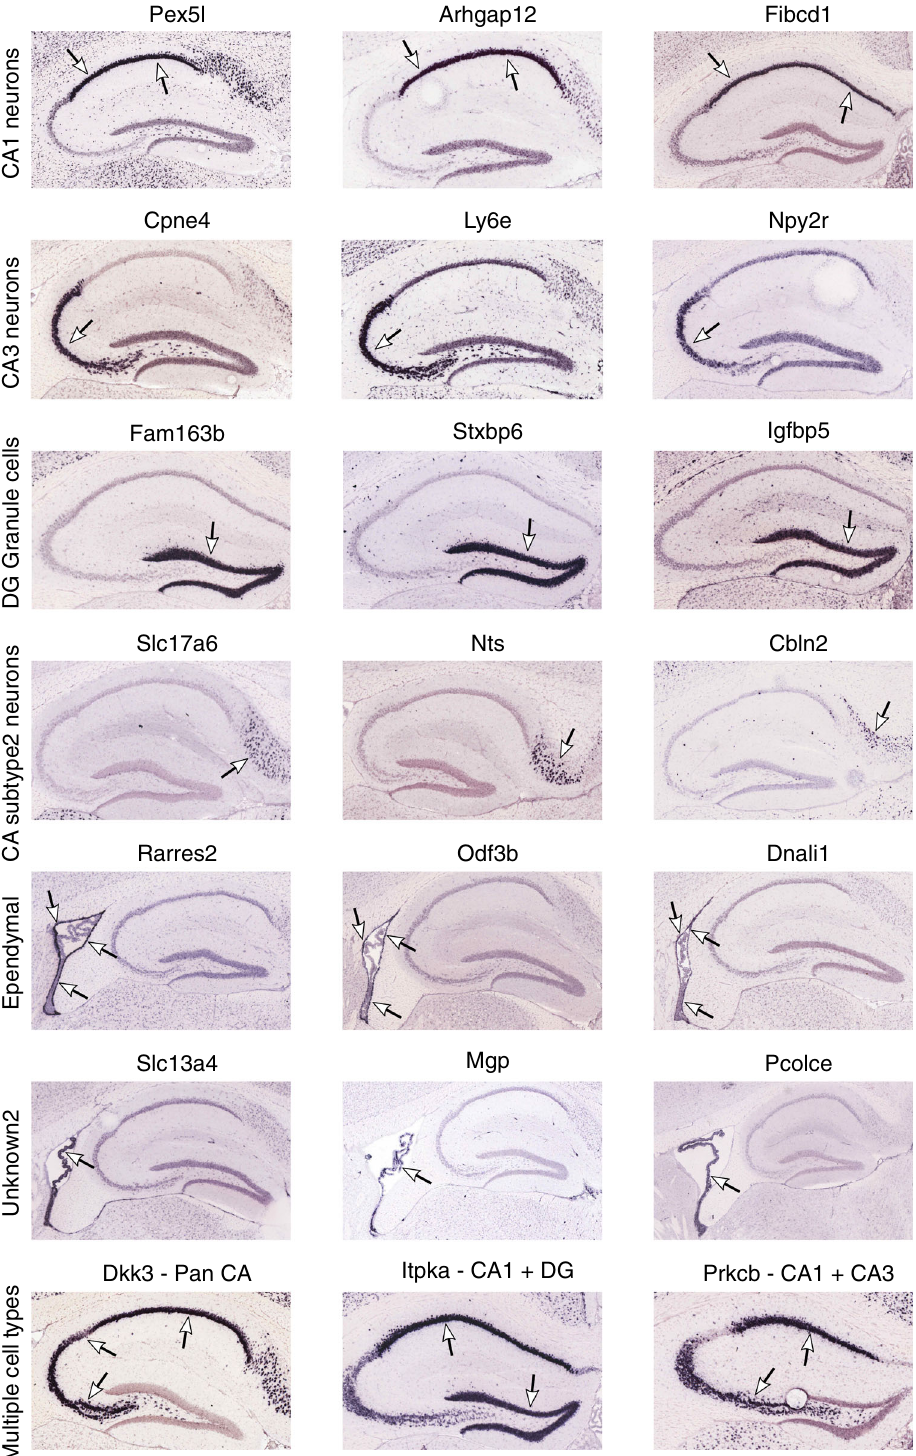
Fig. 2 Cross-validation of novel marker genes for speci fi c neuronal subpopulations. To validate the speci fi city of novel marker genes for neuronal populations and to help resolve the identity of previously unknown cell clusters, we examined the expression patterns of our cell markers in the ISH images from the Allen Brain Atlas 58 . Here, we showcase three select novel genes from four cell types: CA1 neurons, CA3 neurons, DG granule cells, and ependymal cells. Additionally, we showcase marker genes expressed across multiple cell types, genes which resolve the Unknown2 cluster to cells inside the choroid plexus, and genes which help resolve CA Subtype2 Neurons to the Subicular